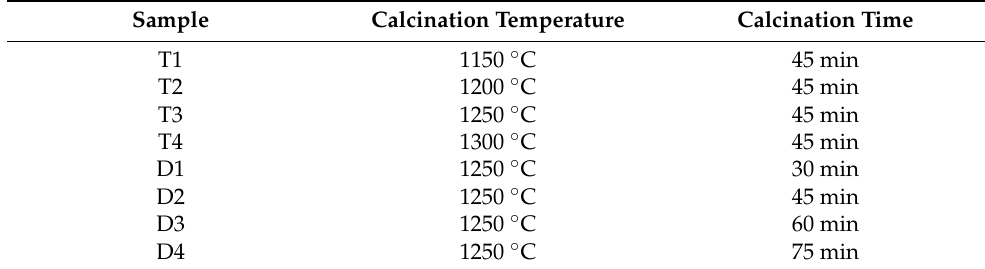
Table 4. Calcination conditions of